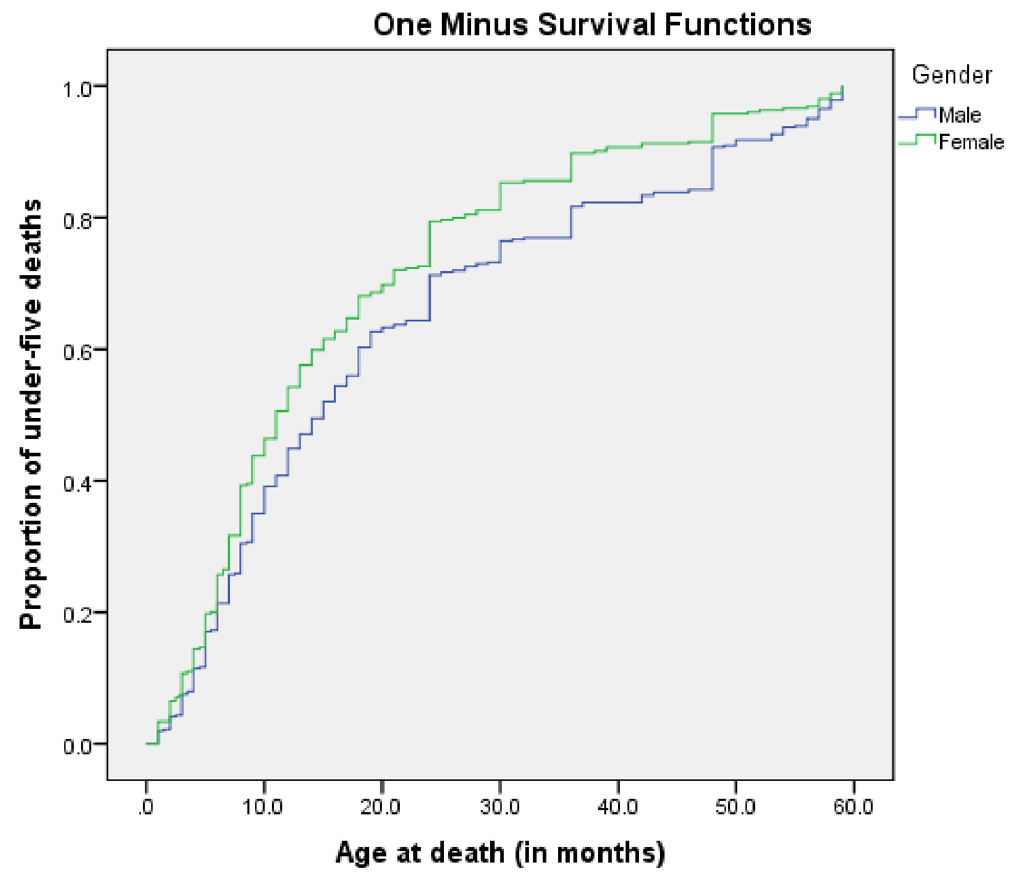
Fig 2. Cumulative proportion of age at death by gender among children under-five years registered at the Infectious Diseases Surveillance Sites in Yaounde´, Cameroon: 2006–2012.